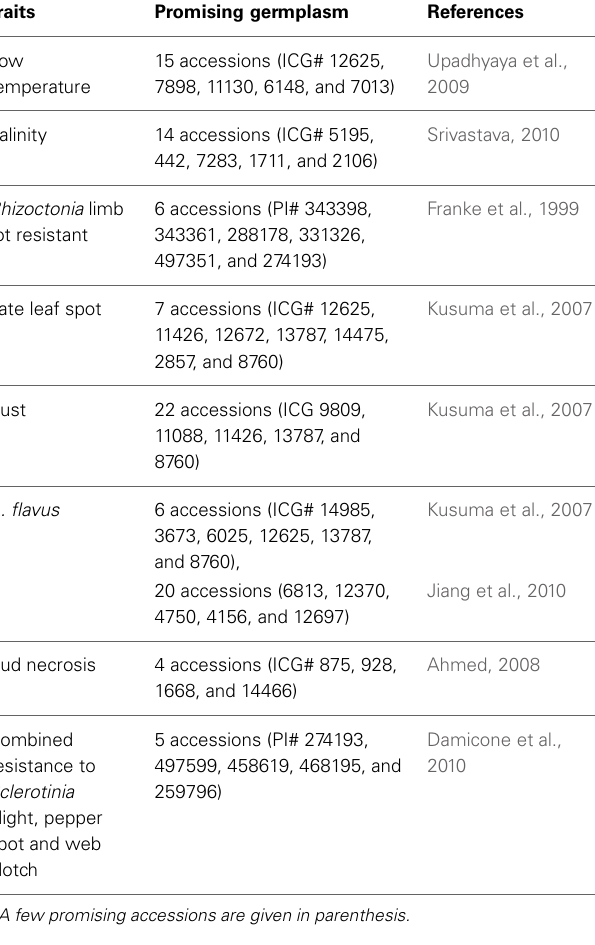
Table 4 | New sources of tolerance/resistance to abiotic/biotic stresses for chickpea, pigeonpea and groundnut